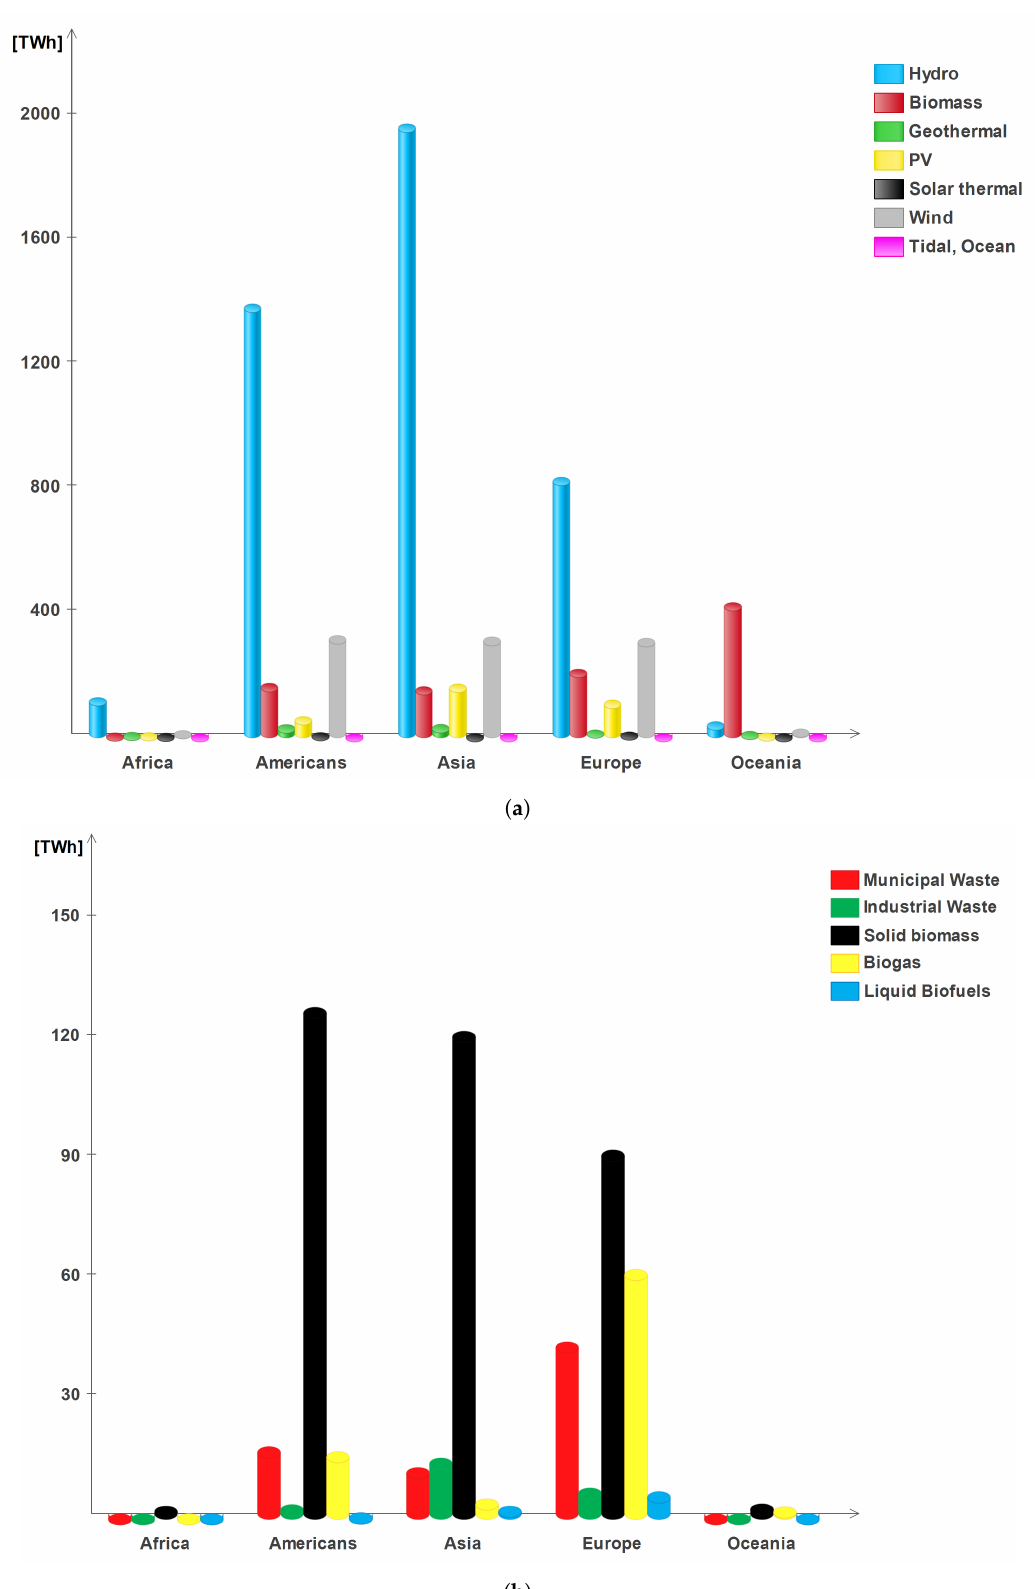
Figure 2. Regional distribution of the electricity generation from ( a ) Renewables and ( b ) Biomass in 2015. Data from: Reference